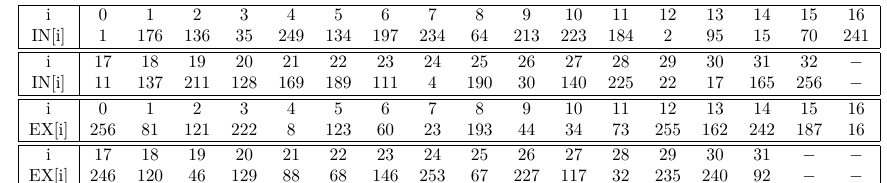
Table 2: The details of IN and